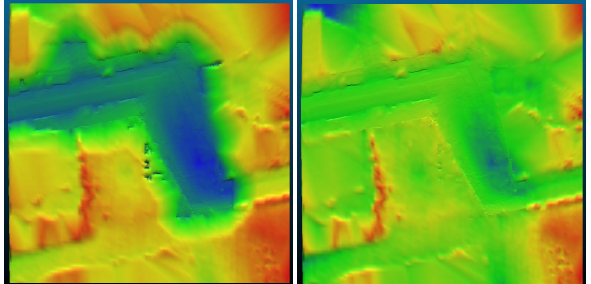
Figure 14. Comparison of DTMs before (left) and after (right) adjustment of the